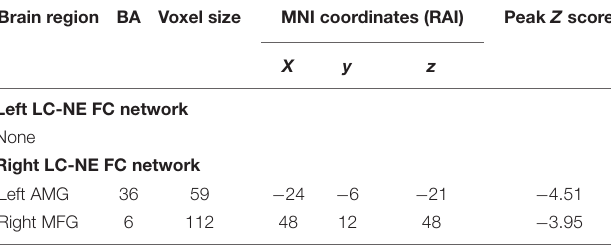
TABLE 3 | Gender differences in bilateral LC-NE FC network in CID group. Brain region BA Voxel size